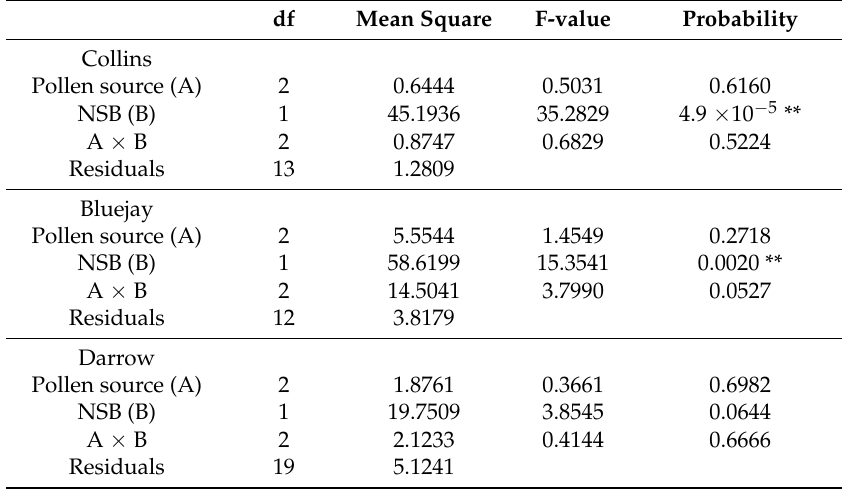
Figure 1. Relationship between the NSB and the DS II ( A – C ), the DS II and the DRF ( D – F ) in Collins ( A , D ), Bluejay ( B , E ) and Darrow ( C , F ) fruits. Fruits were produced by open-pollination (closed circles), hand-pollination with Herbert (shaded circles), and Bluejay (open circles) pollen. Correlation coefficient ( r ) with * or ** is significant at p = 0.05 or p = 0.01, respectively. Table 6. Results of AVCOVA with NSB as the covariate determining the parallelism of the regression lines between NSB and DSII in each pollination by different sources of